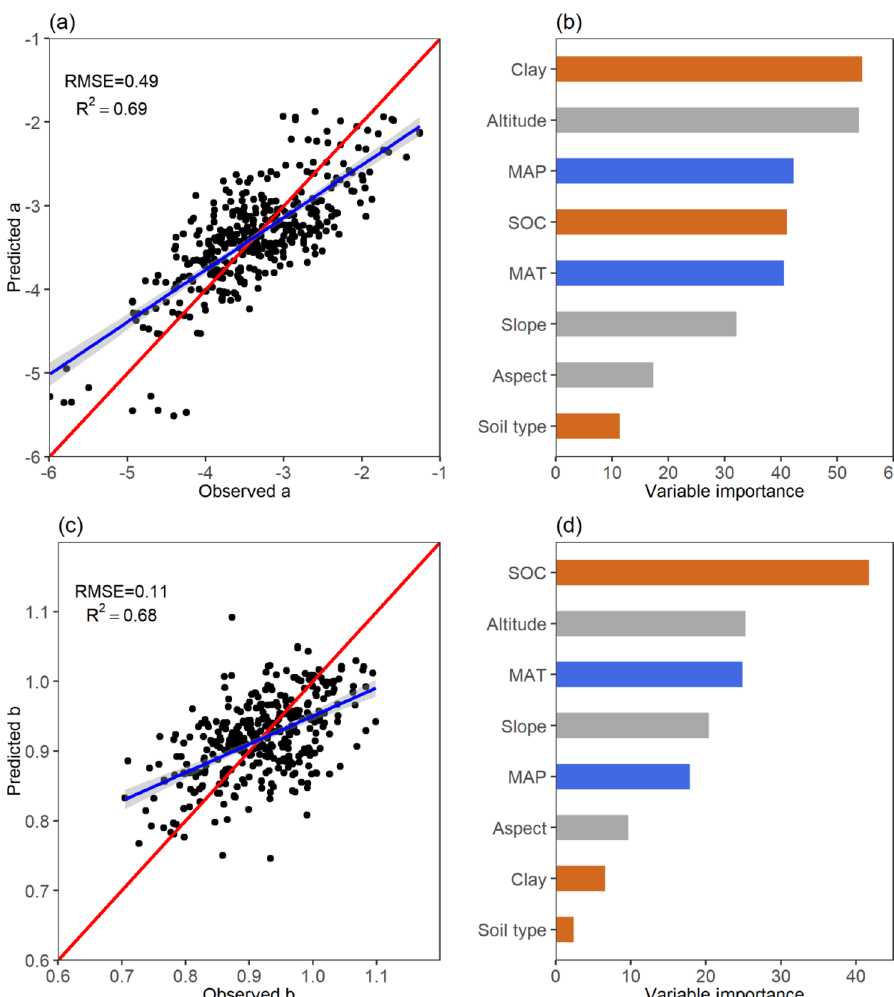
Figure 3. Model performance and variable importance of allometric model (LnW = a + b*Ln(D 2 H)) parameters predictions. ( a ) Model performance for parameter a ; ( c ) Model performance for parameter b . RMSE indicates root mean square error; R 2 indicates R squared. ( b ) Variable importance in predicting parameter a ; ( d ) Variable importance in predicting parameter b . Blue bars represent climatic factors; gray bars represent terrain factors; brown bars represent edaphic